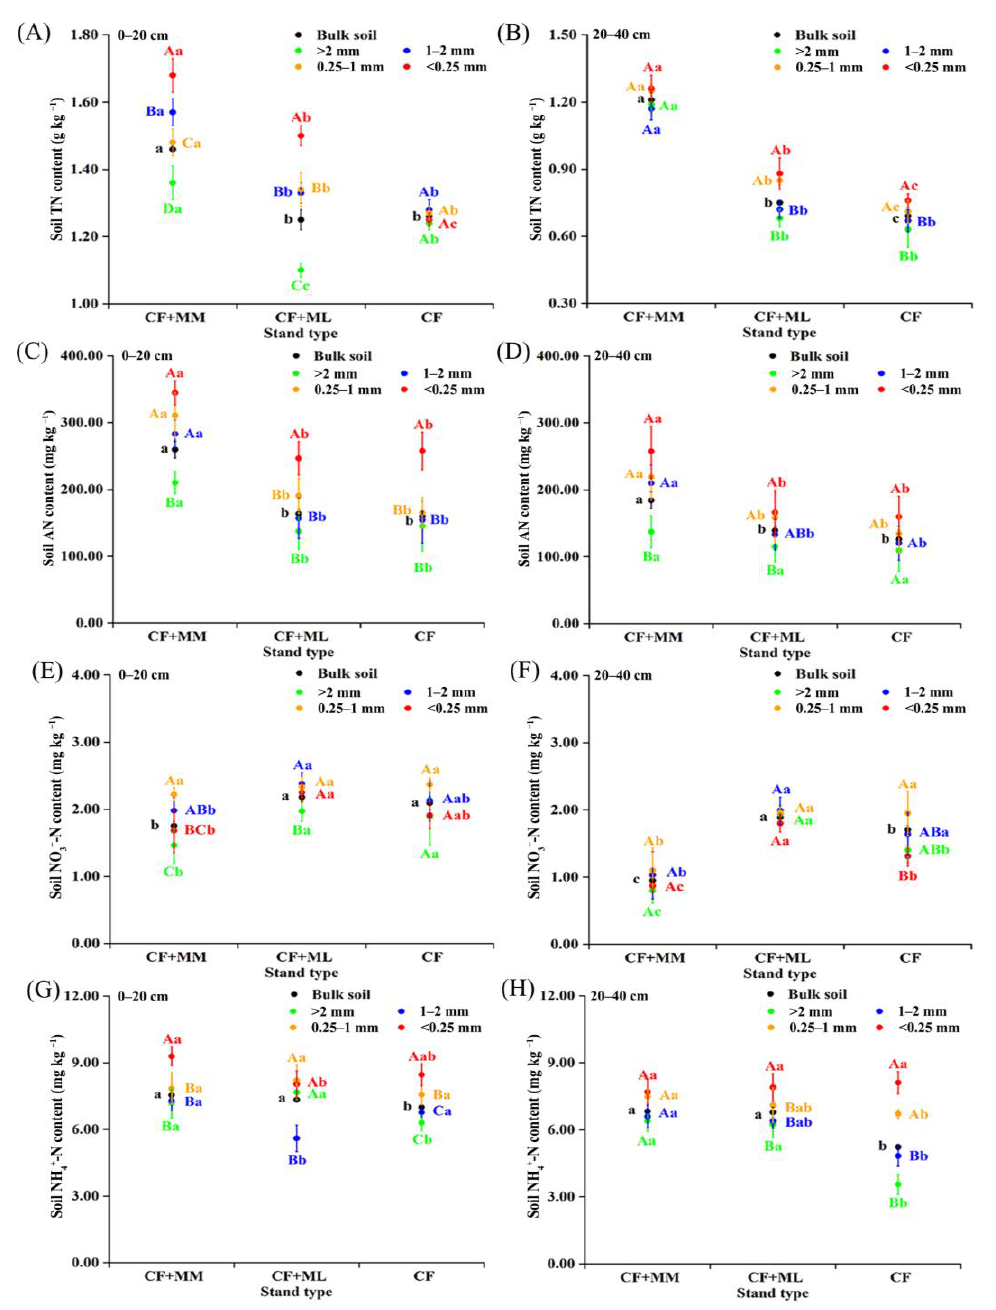
Figure 2. Soil aggregate-associated total nitrogen (TN), available nitrogen (AN), nitrate nitrogen (NO 3 − -N), and ammonium nitrogen (NH 4+ -N) contents in Chinese fir plantations with different stand types in 0–20 cm ( A , C , E , G ) and 20–40 cm ( B , D , F , H ) soil depth. Data represent the mean of five replicates, and error bars represent the standard deviations. CF + MM stands for mixed plantation of Chinese fir and Michelia macclurei . CF + ML stands for mixed plantation of Chinese fir and Mytilaria laosensis . CF stands for pure plantation of Chinese fir. Different capital letters stand for significant differences ( p < 0.05) among different aggregate sizes in the same forest types. Different lowercase letters represent significant differences ( p < 0.05) among different stand types with the same fraction.